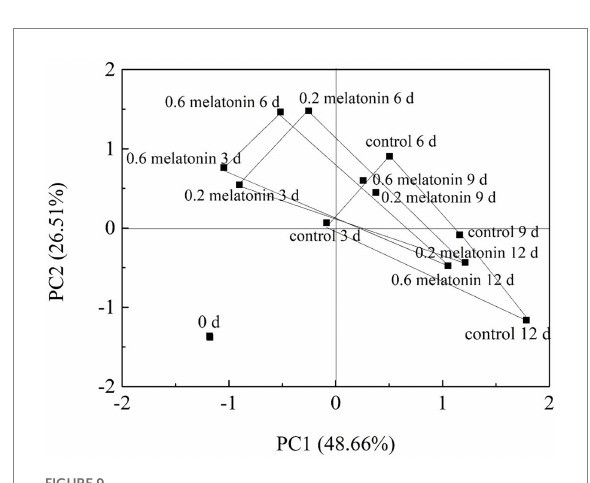
FIGURE 9 Principal component score plots of the control, 0.2,